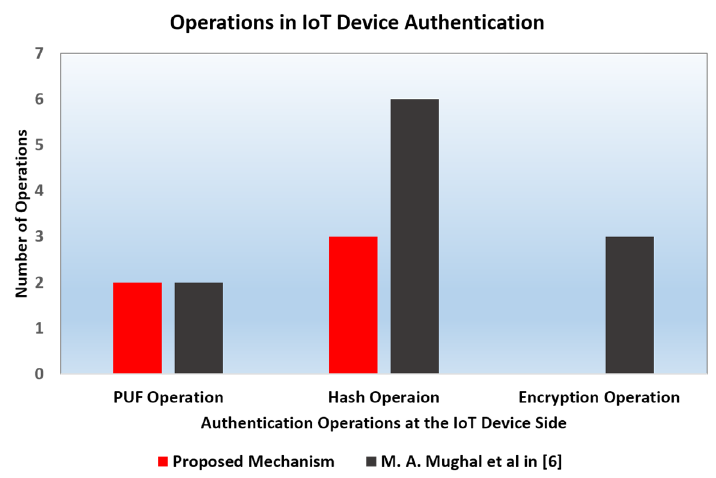
Figure 6. Comparison of the number of operations in IoT device authentication of the proposed mechanism and Mughal et al.’s mechanism.